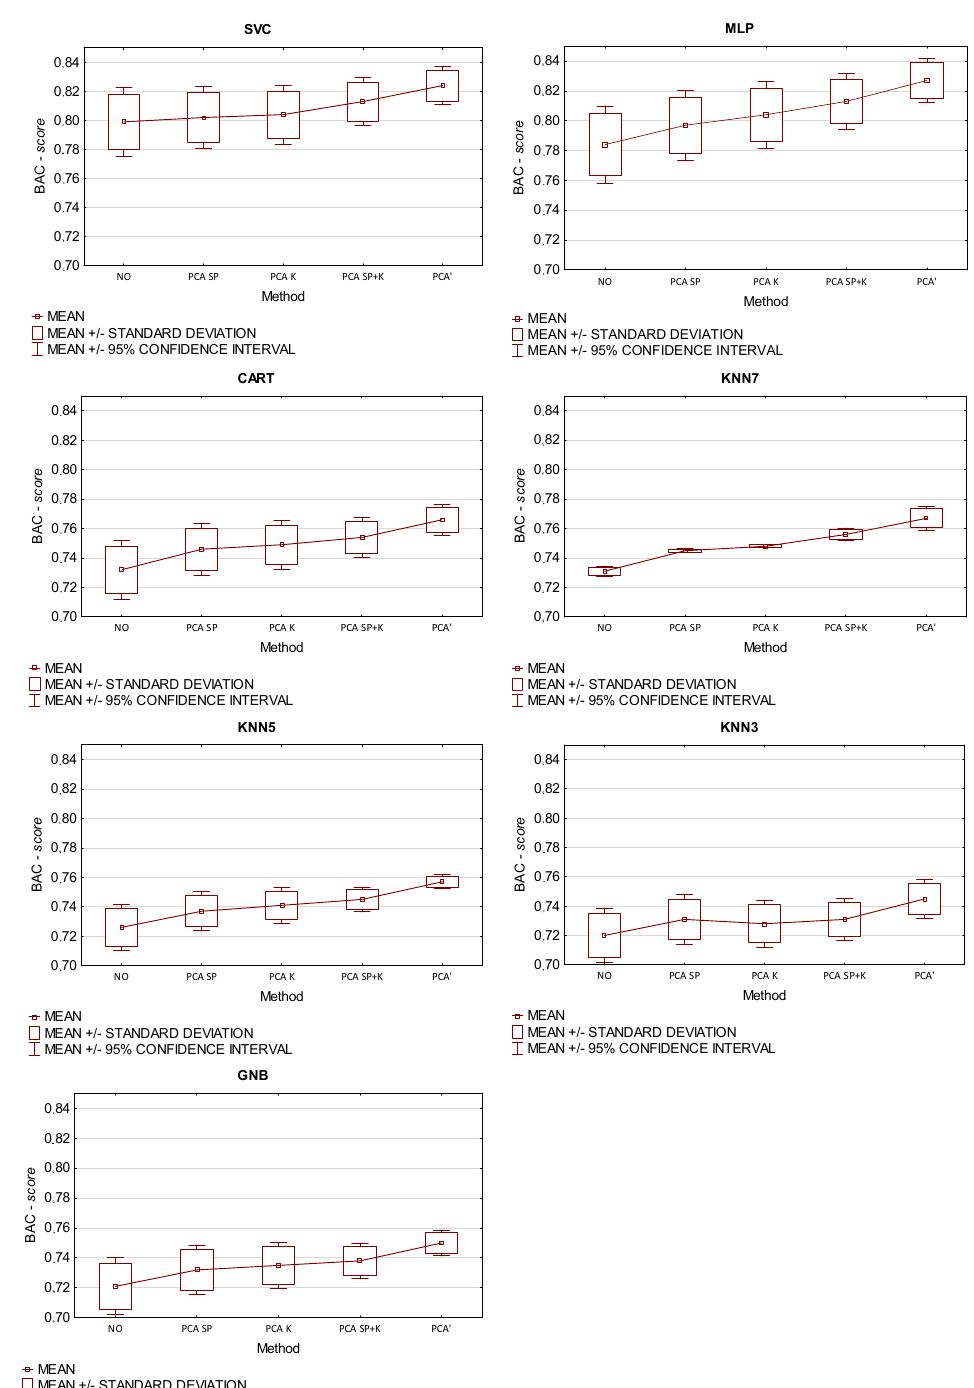
Figure 4. Statistics of the experiment 1 when the proposed method is used to estimate the number of components and features with the BAC- score metric. The lines contain extraction methods and the columns contain